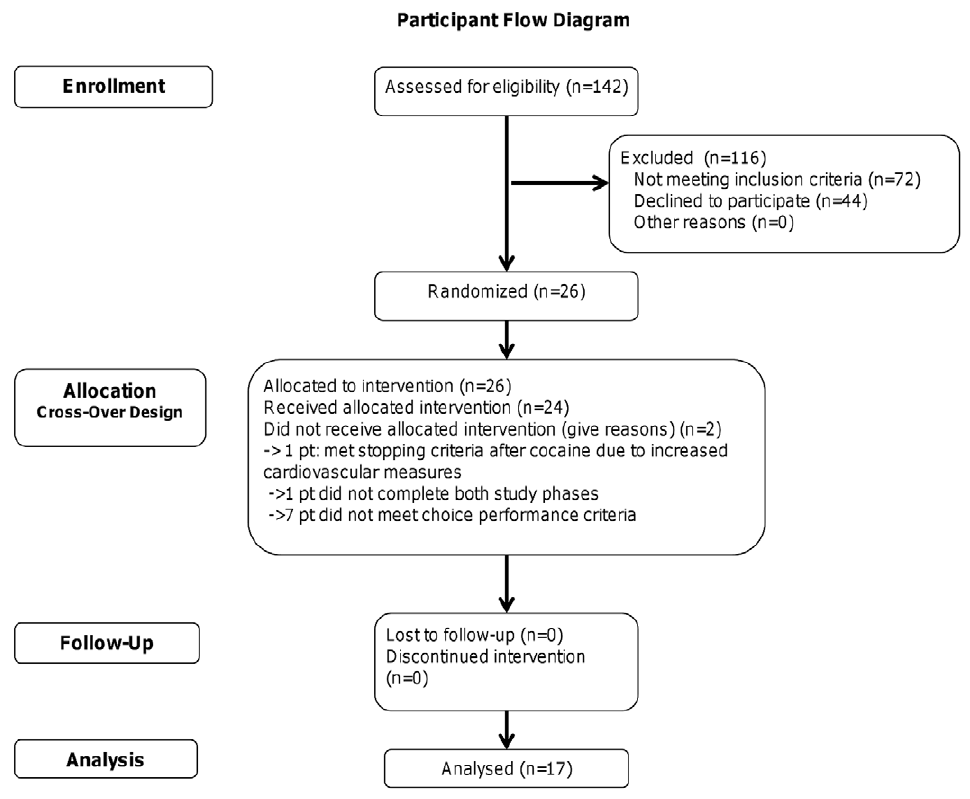
Figure 1. CONSORT Flowchart.